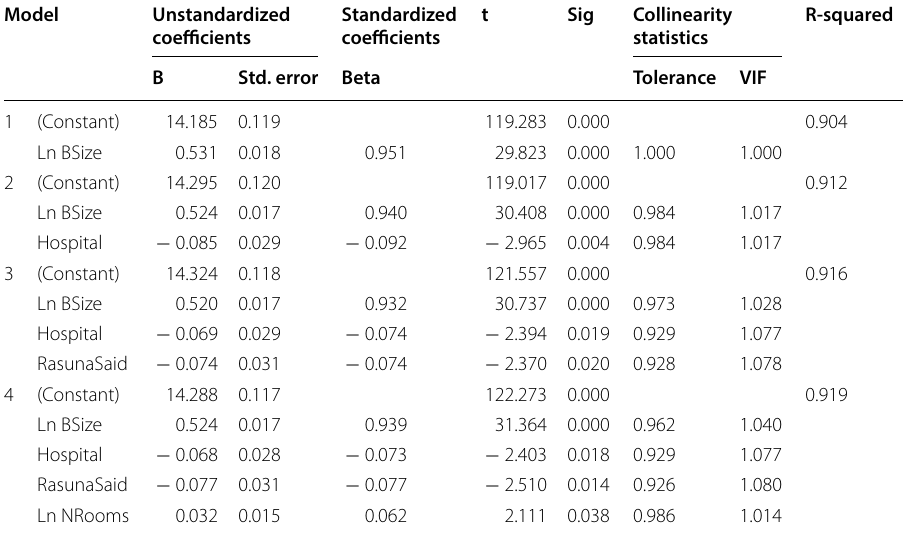
Table 6 Result of multi-collinearity and heteroscedasticity tests